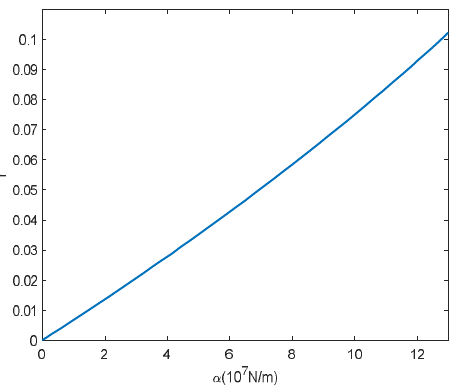
Figure 2. The ratio of the cubic potential energy to the quadratic potential energy of the mechanical (cid:12) (cid:12) (cid:0) (cid:1) m (cid:125) Q 2 s /2 oscillator r = as a function of the mechanical nonlinearity strength α . (cid:12) αβ Q 3 s /3 (cid:12) /